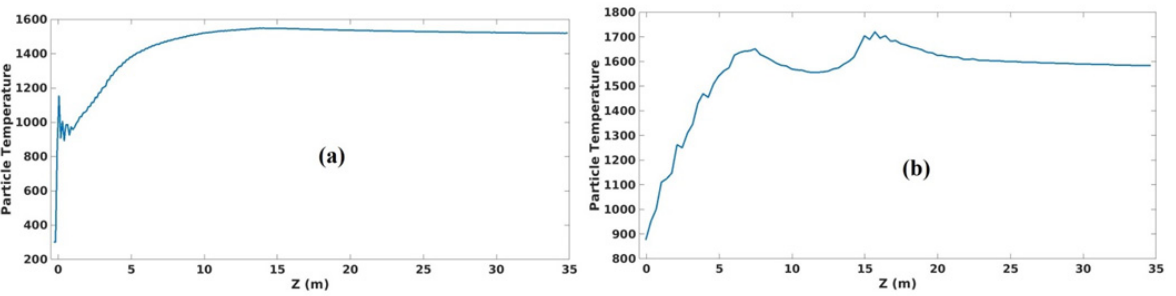
Figure 34. Mass weighted average particle temperature (in K): ( a ) Reactor 1 and ( b ) Reactor 2.